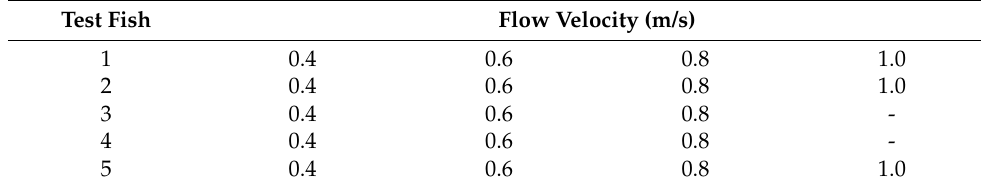
Table 1. Flow velocities for the stepped velocity test.